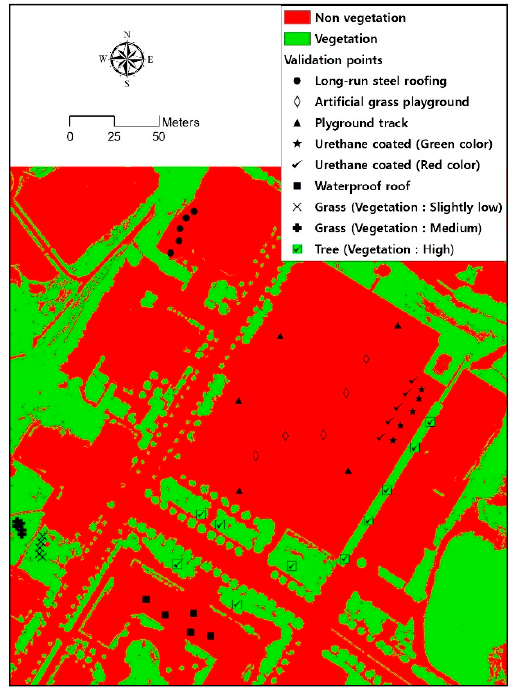
Figure 13. Vegetation map and validation points based on the squared Red-Blue NDVI index. Table 8. Kappa coefficient analysis for vegetation classification.